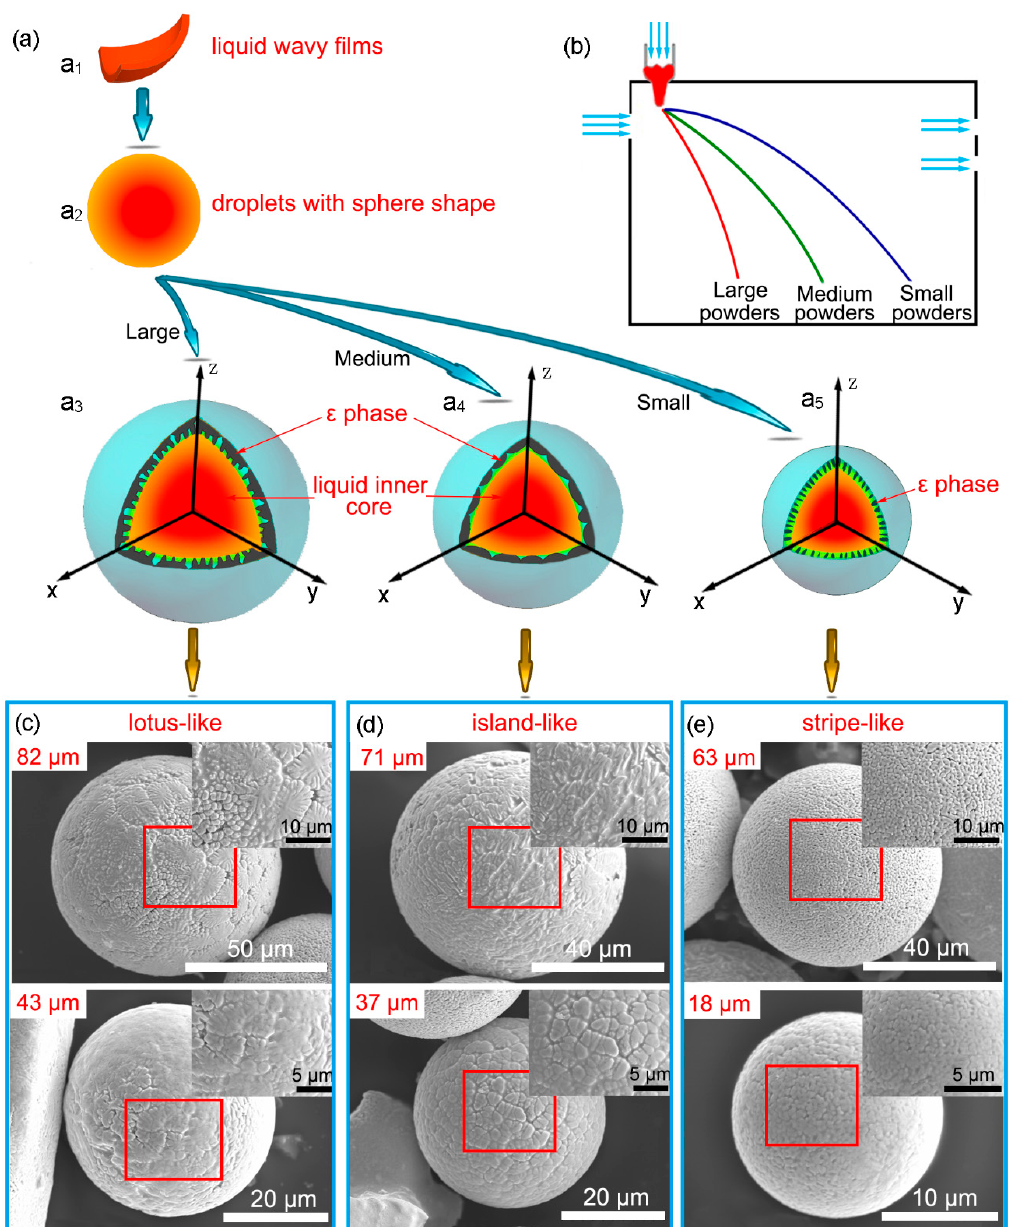
Figure 8. A schematic illustration of the phase transformation mechanism ( a ) as a function of the flying track ( b ); the morphology of powders without corrosion with a series of diameters of ( c ) 82 μ m and 43 μ m, ( d ) 71 μ m and 37 μ m, and ( e ) 63 μ m and 18 μ m.